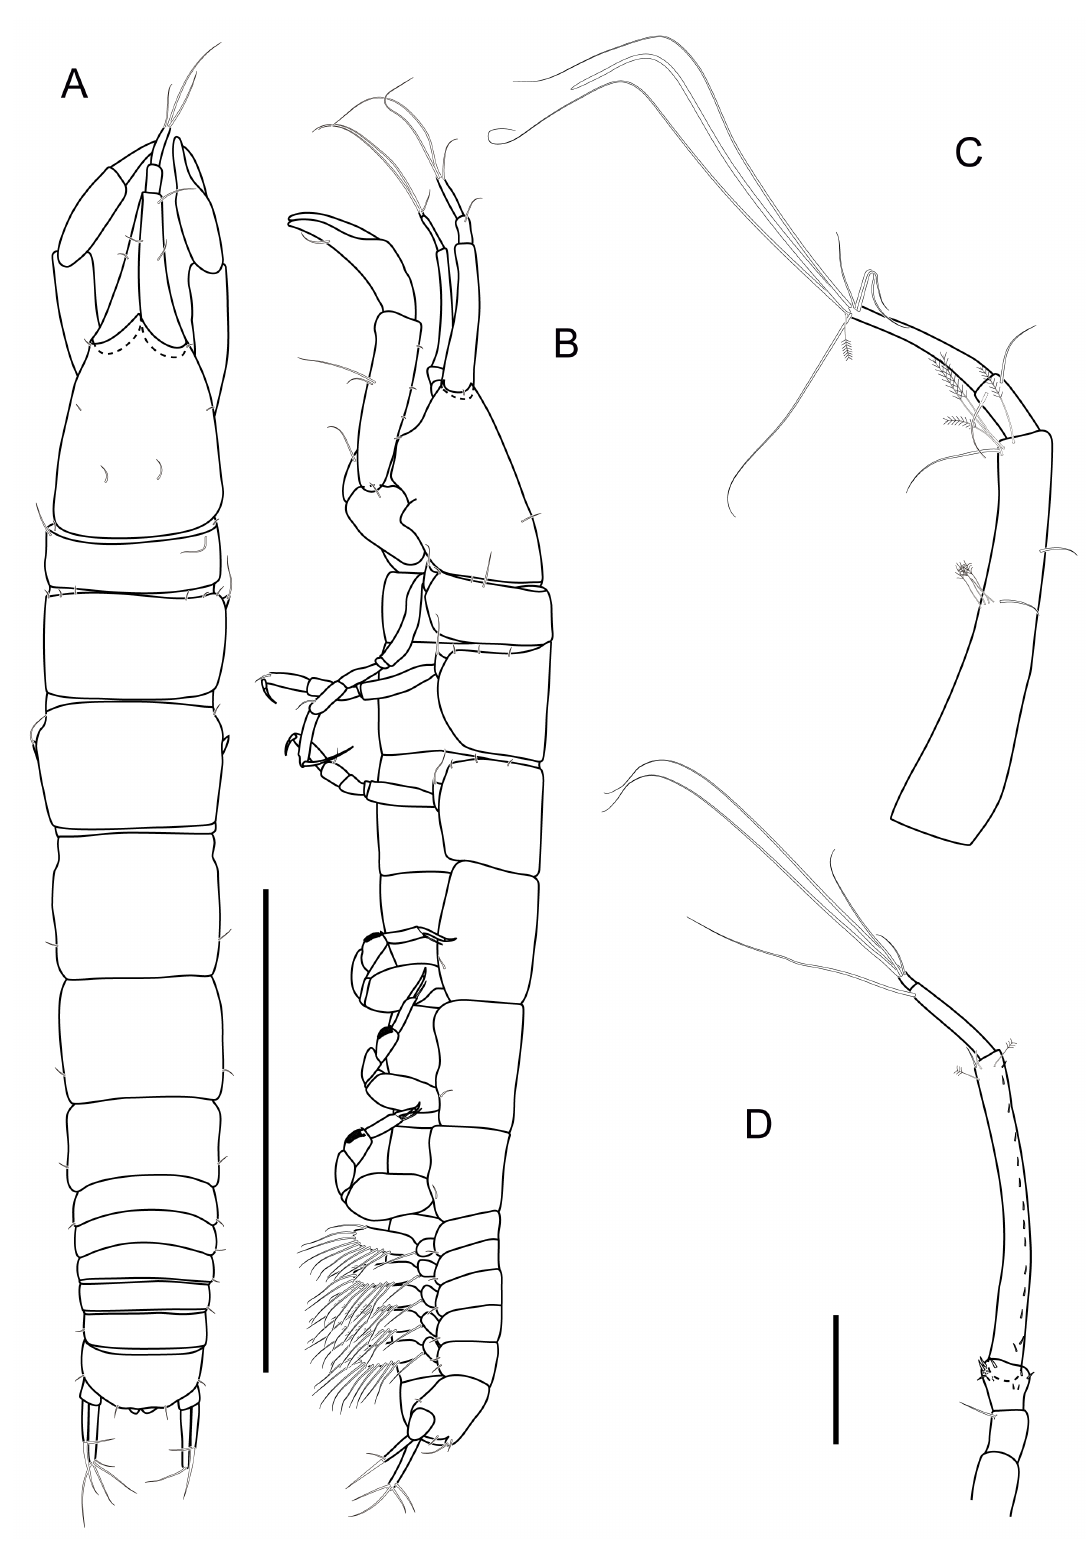
Fig. 11. Typhlotanais ischnochela sp. nov. A–B . ♀ (MZUSP 34444). A . Dorsal view. B . Lateral view. C–D . Paratype (MZUSP 34428), ♀, dissected. C . Antennule. D . Antenna. Scale bars: A–B = 1 mm; C–D = 0.1